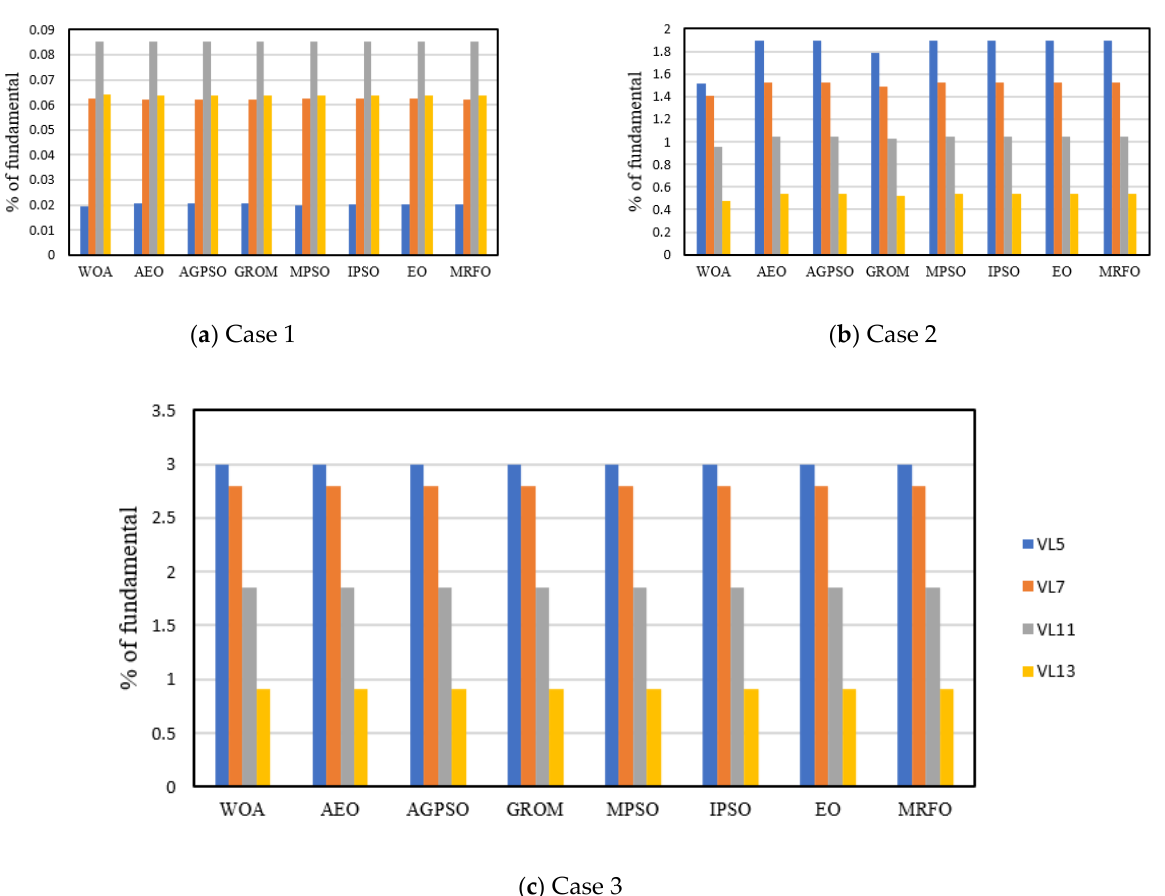
Figure 4: The individual voltage harmonics for configuration 1 of HAPF under the proposed three cases.